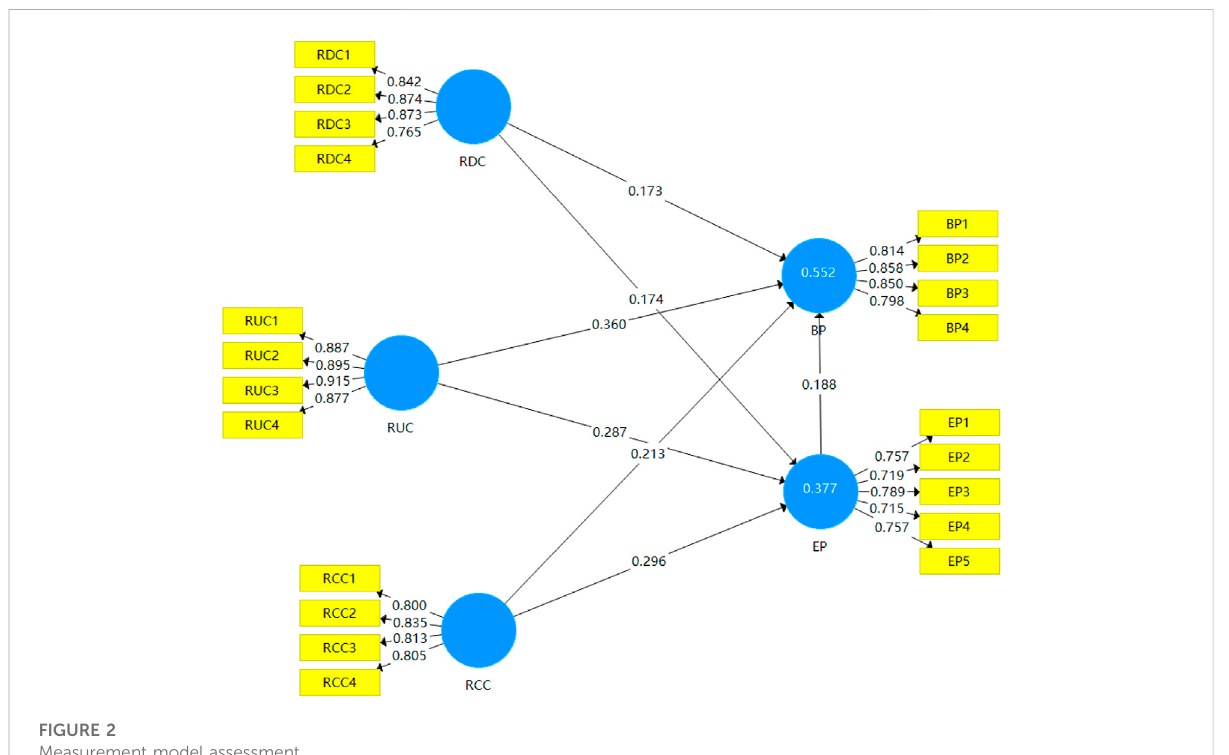
FIGURE 2 Measurement model assessment.